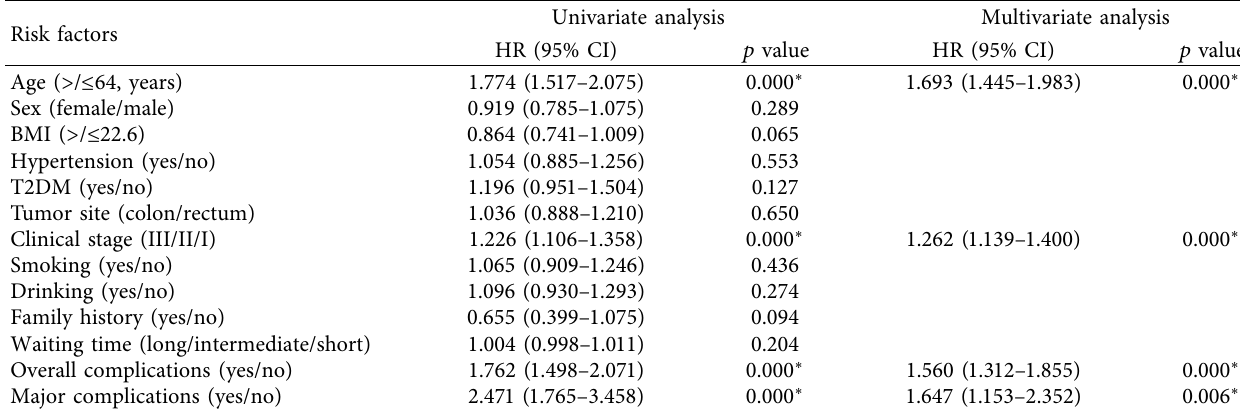
Table 4: Univariate and multivariate analysis of disease-free